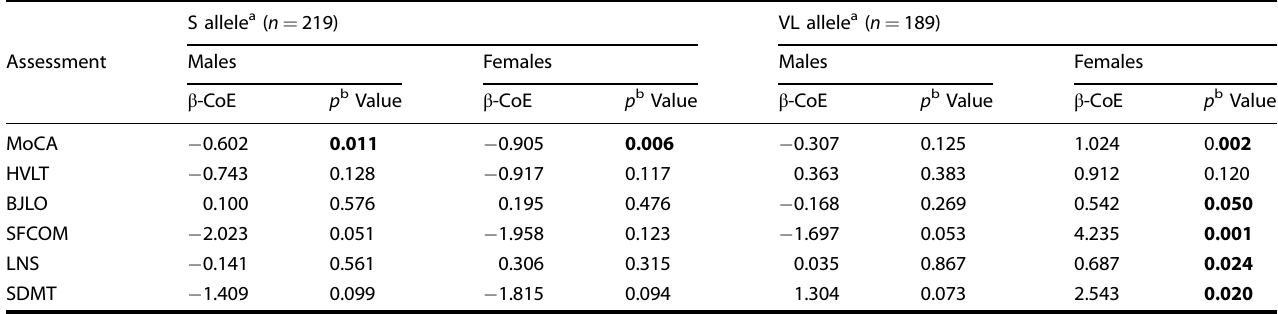
Table 3. Summary of differential associations of TOMM40 alleles with longitudinal cognitive measures in male and female APOE ε 3/ ε 3 carriers in the PPMI